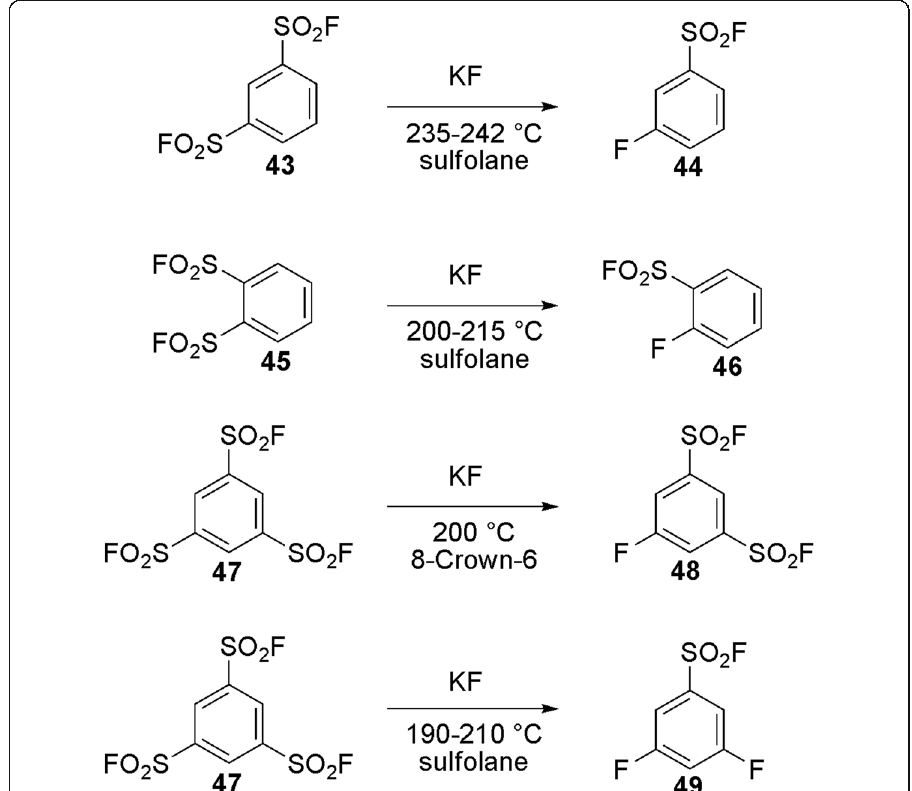
Fig. 13 Synthesis of arylfluorides by desulfurization of